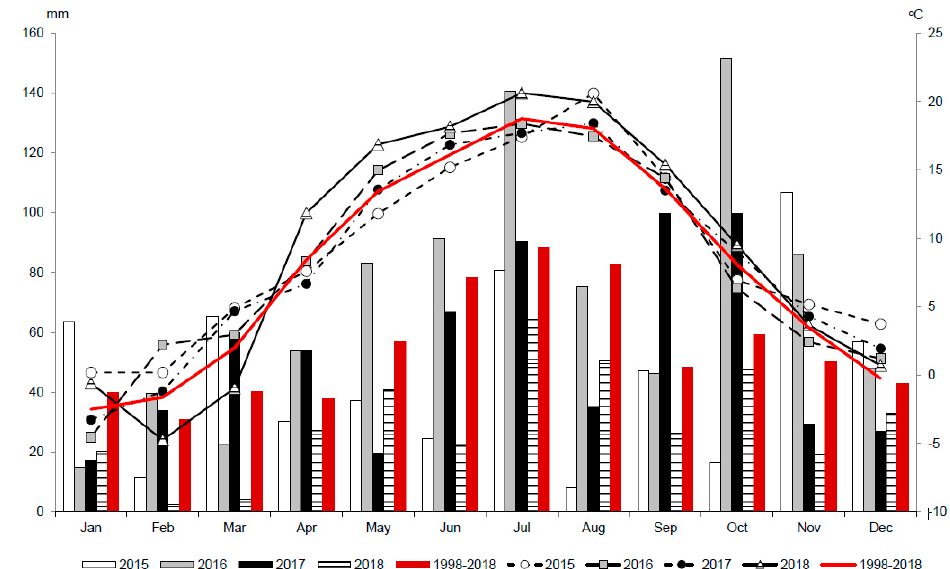
Figure 1. Weather conditions during the experimental period of 2015–2018 and the referenced long-term average (1998–2018). Bars represent precipitation and curves represent air temperatures.